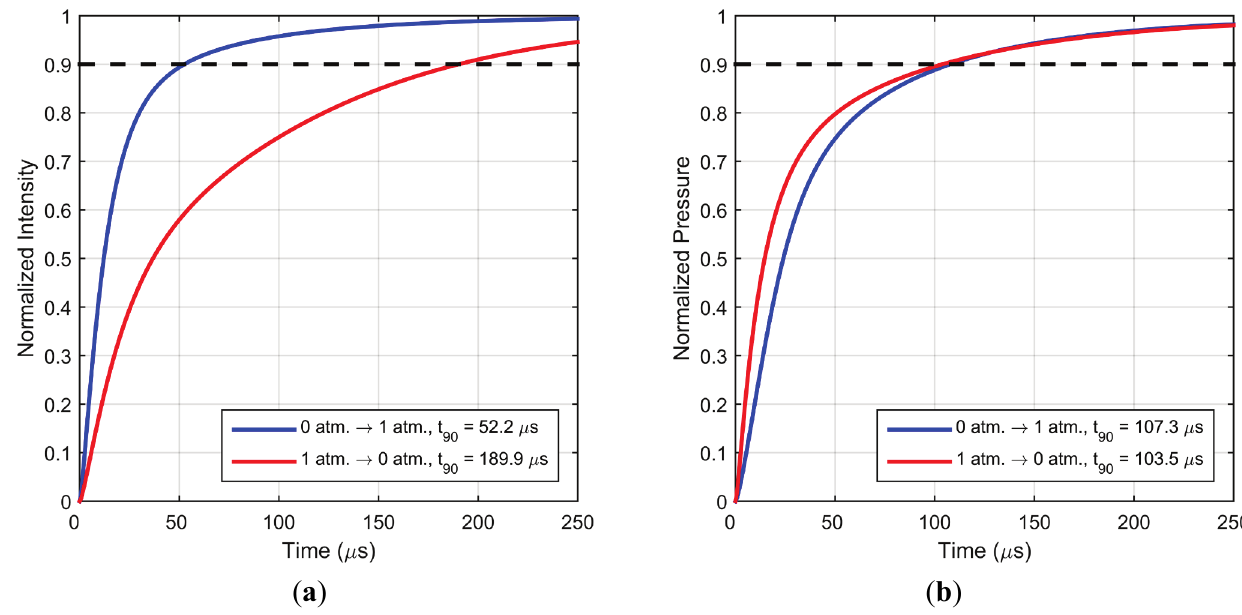
Figure 10. ( a ) Simulated intensity response; ( b ) Simulated pressure response for a typical sample for a step change in pressure between vacuum and 1